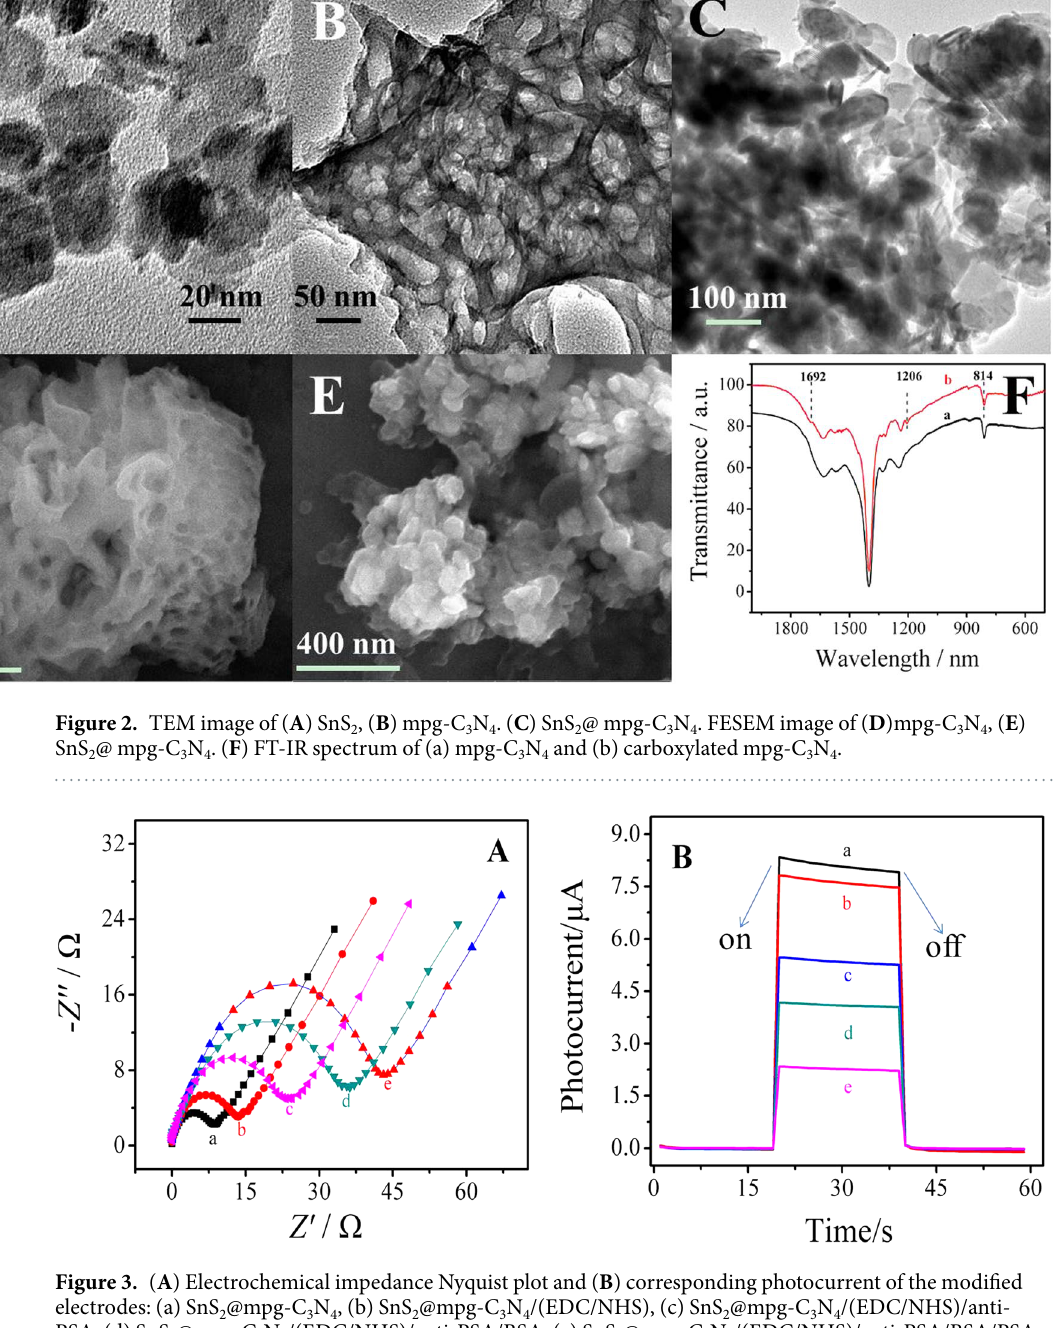
Characterization of the PEC immunosensor fabricating process. The electrodes had different inter- face properties and photocurrent responses at different modification stages, which were characterized by electro- chemical impedance spectroscopy (EIS) (Fig. 3A) and photocurrent measurement (Fig. 3B) respectively. In the EIS experiments, our instrument parameters of frequency range and amplitude were set as 100 mHz ~ 100 KHz and 5 mV respectively. The bias voltage remained the default 0 V. The buffer solution used in the tests was a kind of mixed solution containing 2.5 mmol·L − 1 K 3 [Fe(CN) 6 ], 2.5 mmol·L − 1 K 4 [Fe(CN) 6 ] and 0.1 mol·L − 1 KCl. As shown